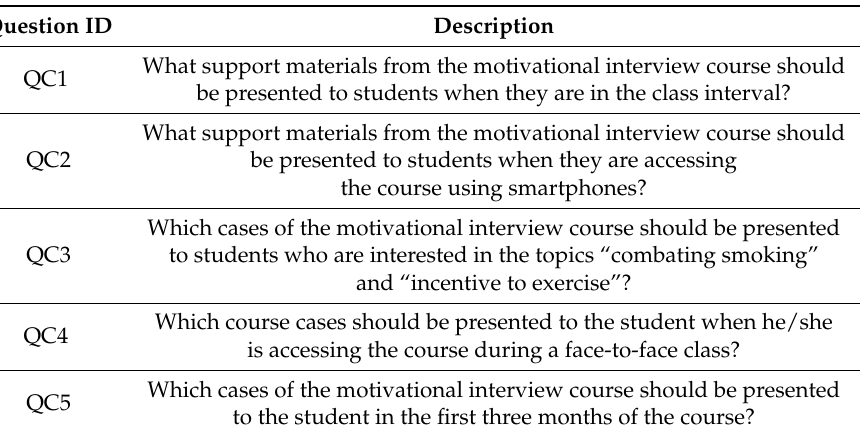
Table 3. Competence questions.